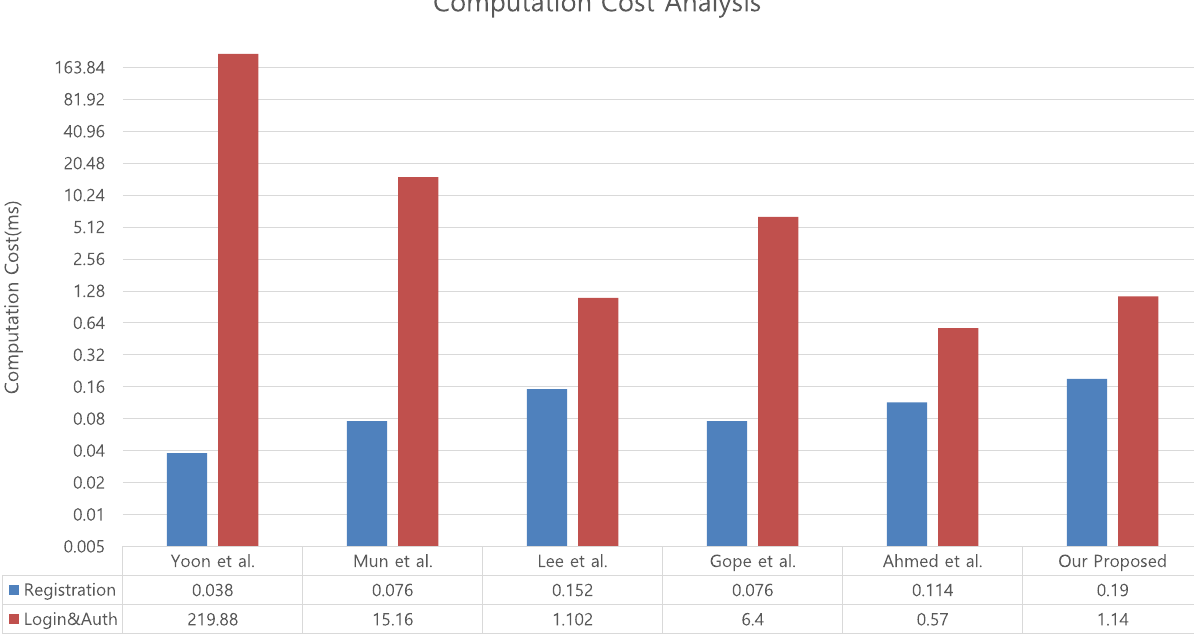
Fig 20. Computation cost analysis between proposed scheme and existing schemes.